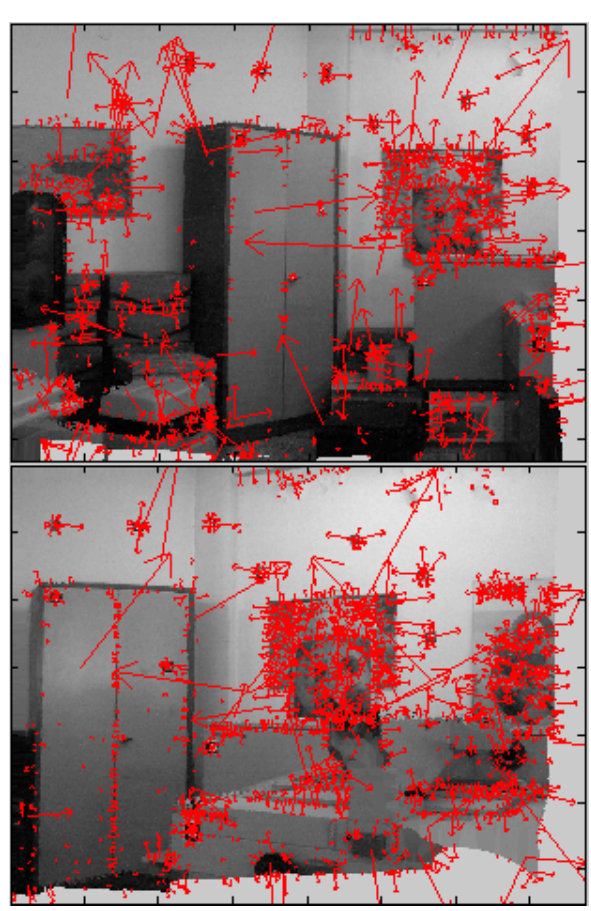
Figure 2. Overlapping point clouds from two stations.